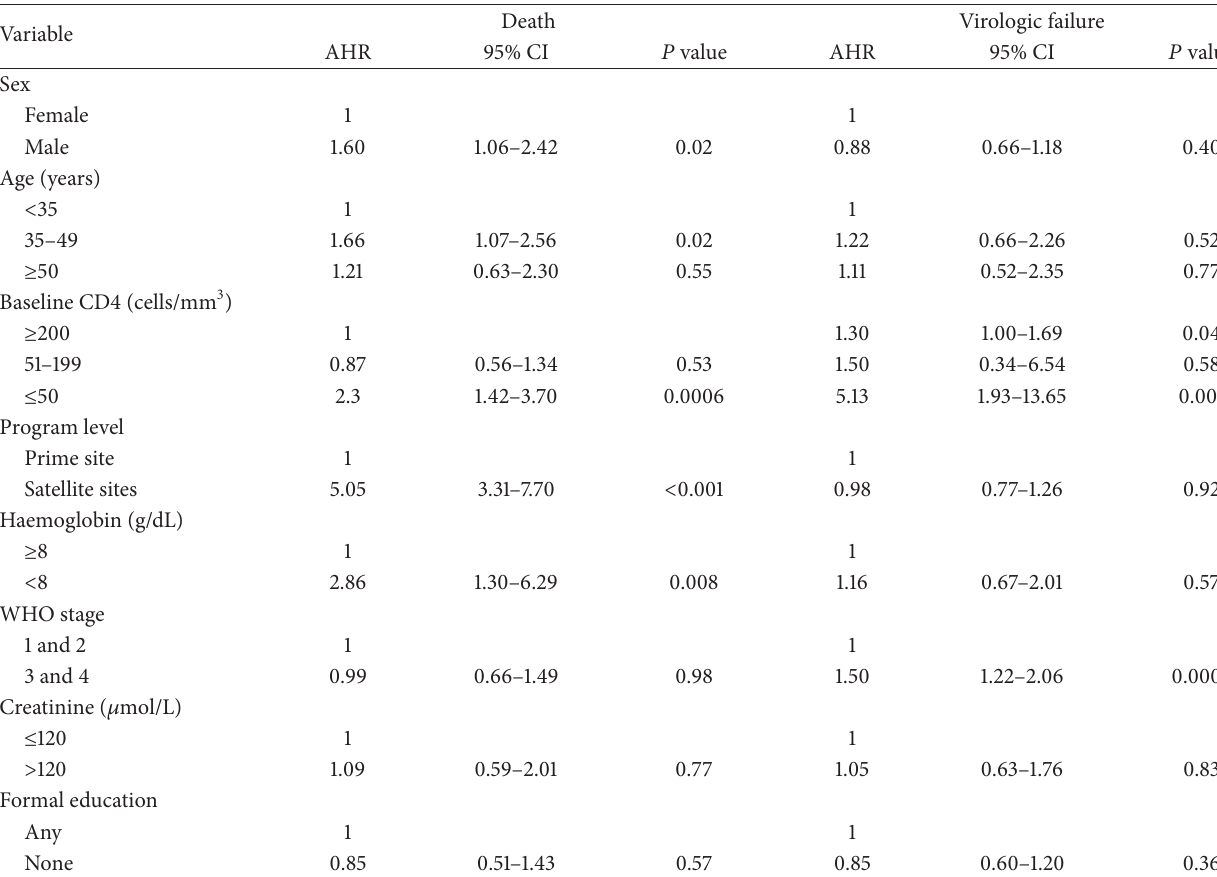
Table 4: Risk factors for death within 12 months and virologic failure in patients initiating ART in a decentralized HIV treatment program (2007–2011) in Jos,